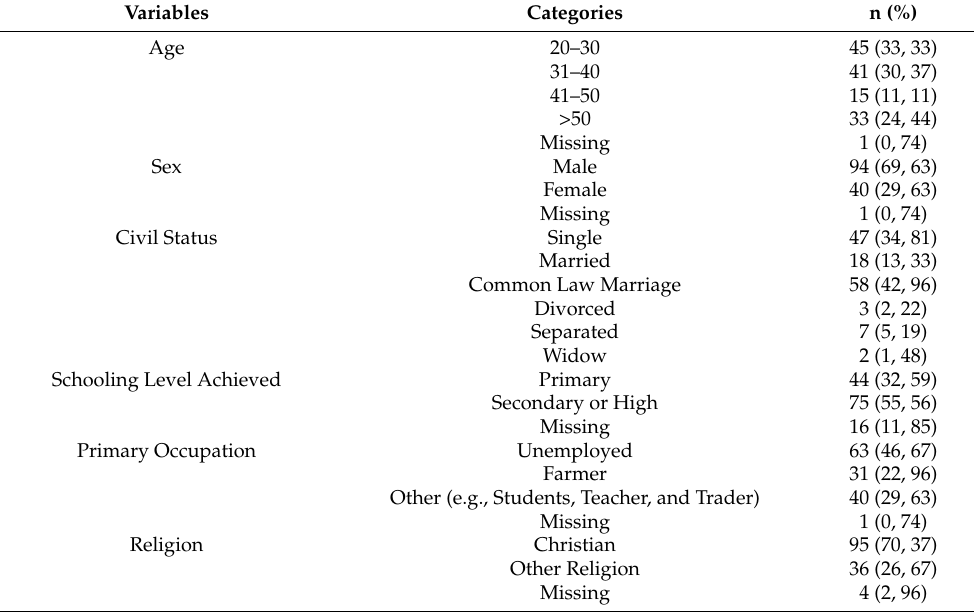
Table 1. Sociodemographic description of 135 community health workers in nine districts of Sofala Province, Mozambique.